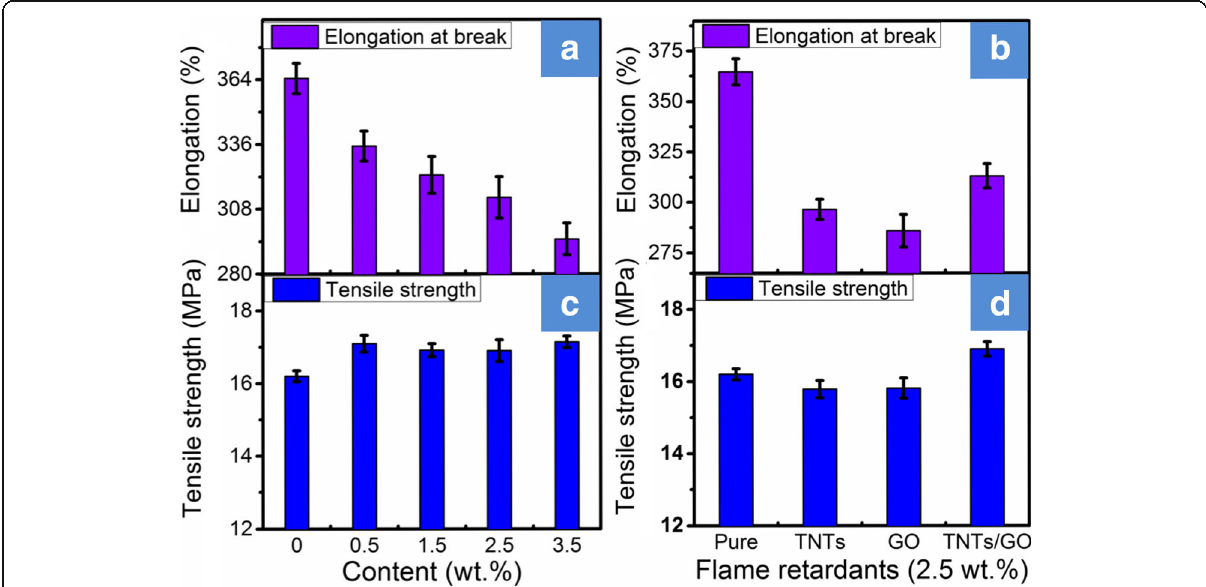
Fig. 5 Tensile strength and elongation at break of flexible PVC and PVC-matrix composites with various content of TNTs/GO ( a , c ) and with 2.5 wt.% of GO or of TNTs and TNTs/GO ( b , d ). The incorporated TNTs/GO to PVC could enhance the tensile strength of the PVC-matrix compos- ites, because the TNTs/GO nano-filler exhibits good exfoliation and dispersion that enhance the interfacial adhesion with the PVC matrix